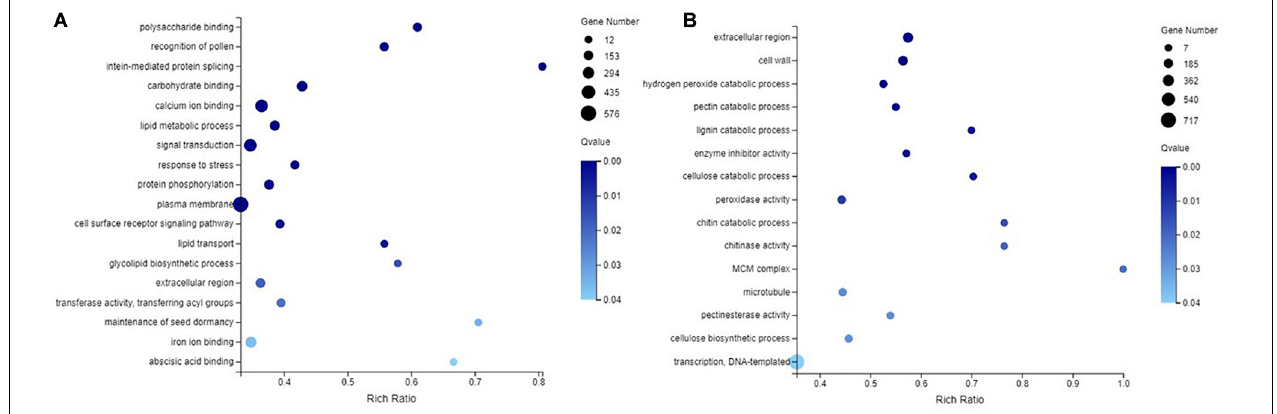
FIGURE 6 | GO enrichment analysis in NM-NMP (A) NMP-AMP (B) . NM = uninoculated with S. tortuosa , NMP = NM inoculated with C. lentis .